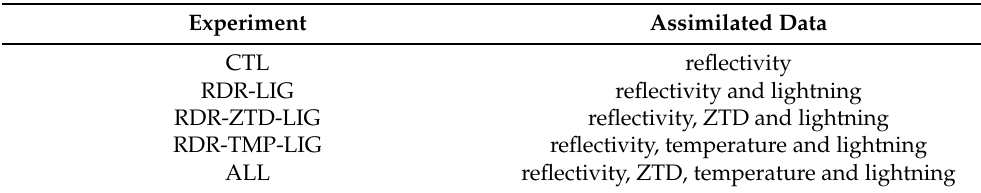
Table 1. List of numerical